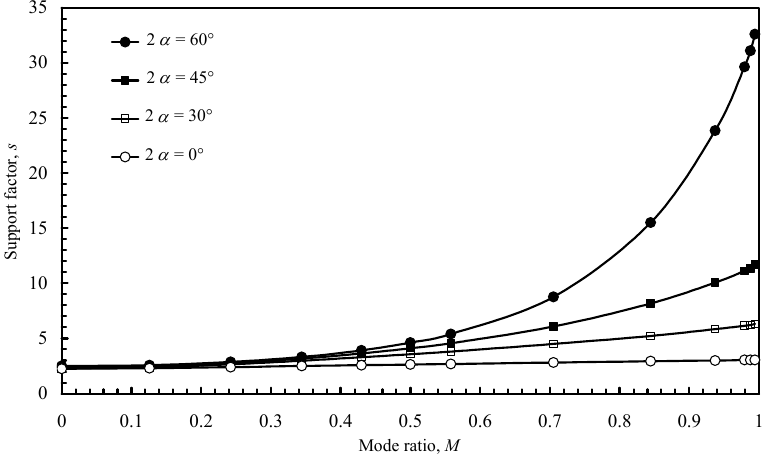
Figure 2: Support factor s as a function of the mode ratio M for different values of the notch opening angle 2 